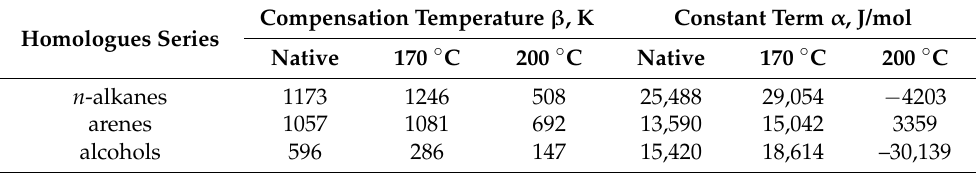
Figure 7. Compensation curves for poly(3-(tributoxysilyl)tricyclononene-7) (PTBSN) in the initial state for homologues series of n -alkanes and arenes. Table 4. Parameters of the compensation equation ∆ H = β ∆ S + α for homologues series of n-alkanes, and alcohols for poly(3-(tributoxysilyl)tricyclononene-7) (PTBSN) in the native state and after ageing at 170 and 200 ◦